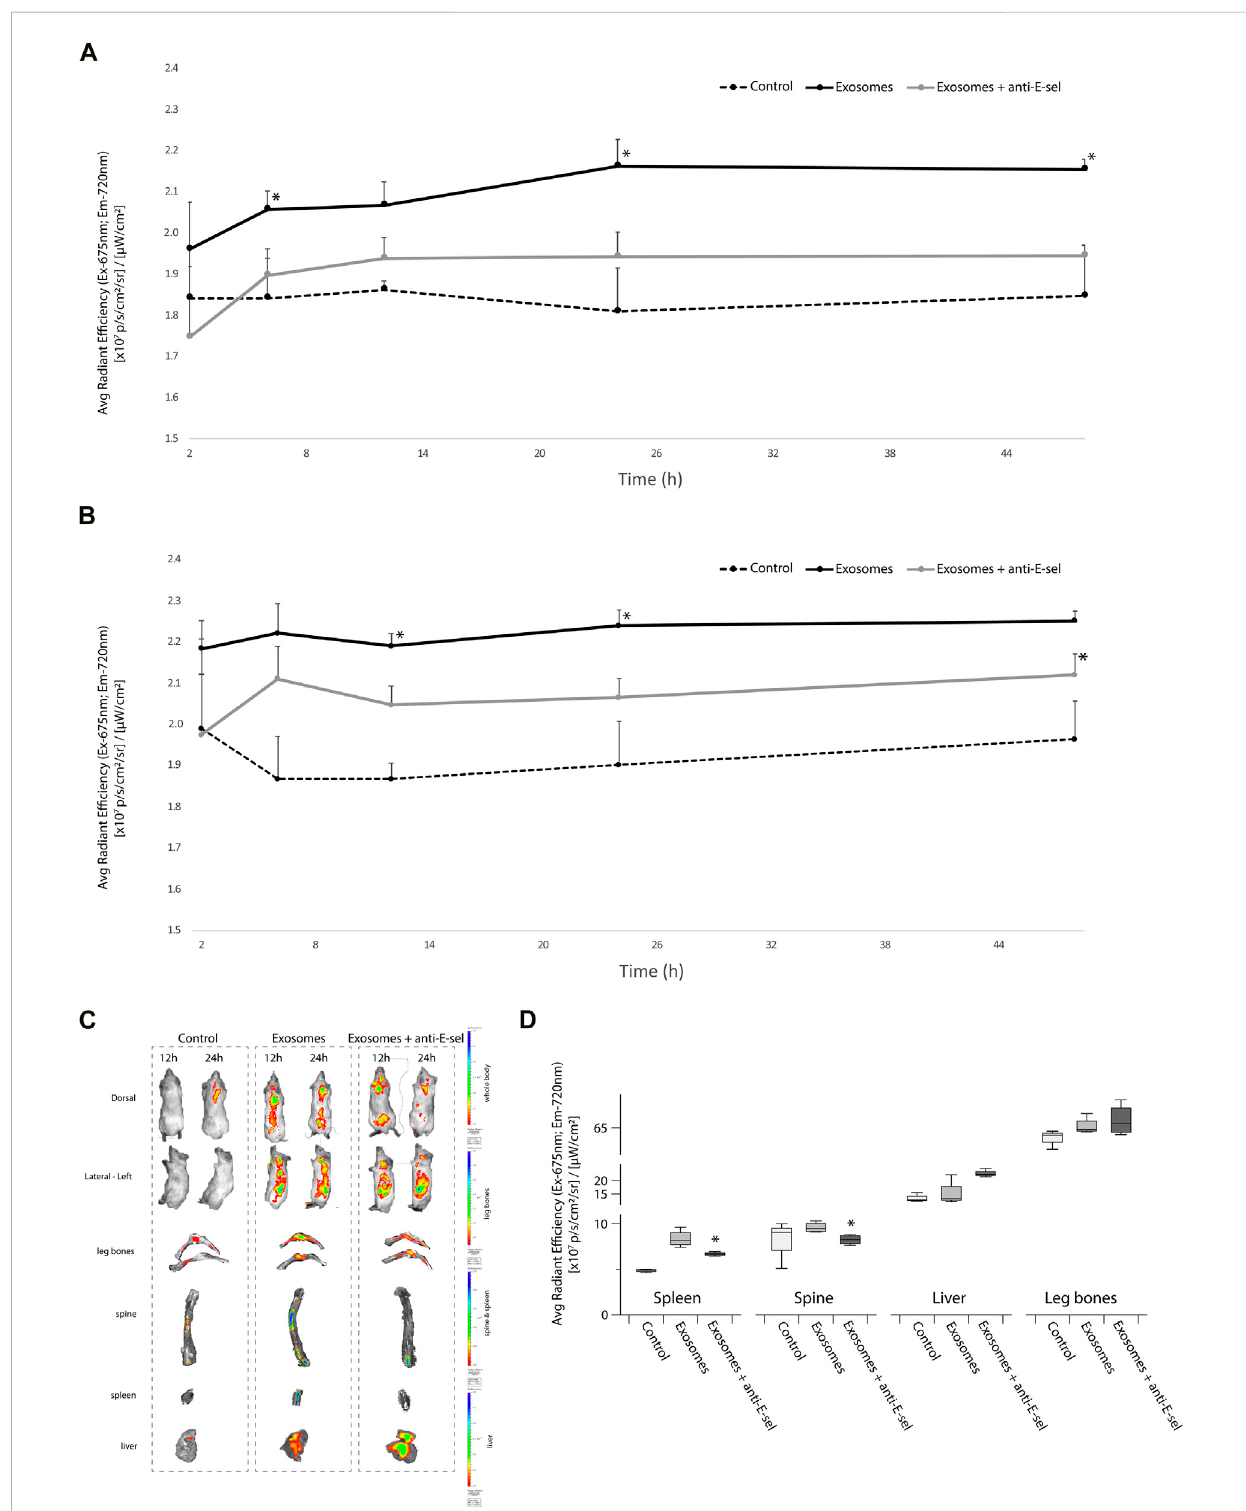
FIGURE 5 In vivo biodistribution of exosomes is in fl uenced by E-selectin. KG1a-derived exosomes were prestained with VivoTrack 680 and delivered to NSG miceintravenously via thetailvein.NSGrecipientswereeitherpretreatedwithblockinganti-E-selectinantibody3 hpriortoexosomedelivery(exosomes + anti-E-sel) or left untreated (exosomes). Control group mice that did not receive exosomes. (A) Quantitative analysis of fl uorescence intensity, statisticallyanalyzedbystudent ’ st-test,usingIVISimagingofthewholebodyofNSGmiceinthedorsalpositionat2,6,12,24,and48 hisshown.The dorsal position is helpful to detect the fl uorescence signal from the spine ( p -value (*) < 0.05, Exosomes group vs. Exosomes + anti-E-sel group). (B) Quantitative analysis of fl uorescence intensity, statistically analyzed by student ’ s t-test, using IVIS imaging of the whole body of NSG mice in the left- lateral position at 2, 6, 12, 24, and 48 h is shown. The left-lateral position is helpful to detect the fl uorescence signal from the spleen ( p -value (*) < 0.05,